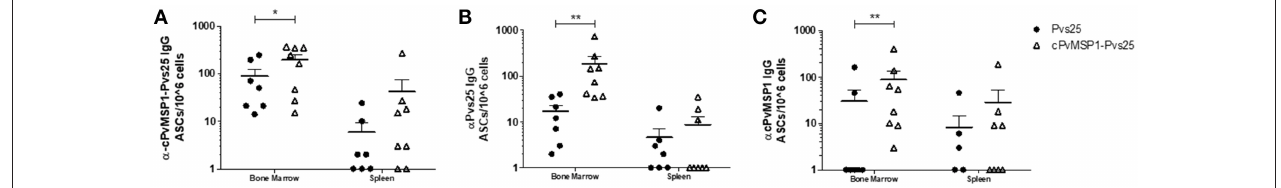
FIGURE 5 | IgG-producing long-lived plasma cells. Antigen-specific IgG plasma cells present in the bone marrow or spleen of CB6F1/J mice immunized with Pvs25 (closed circles, n = 7), cPvMSP1-Pvs25 (open triangles, n = 8) were analyzed at two years post first immunization. IgG long-lived plasma cells specific to (A)